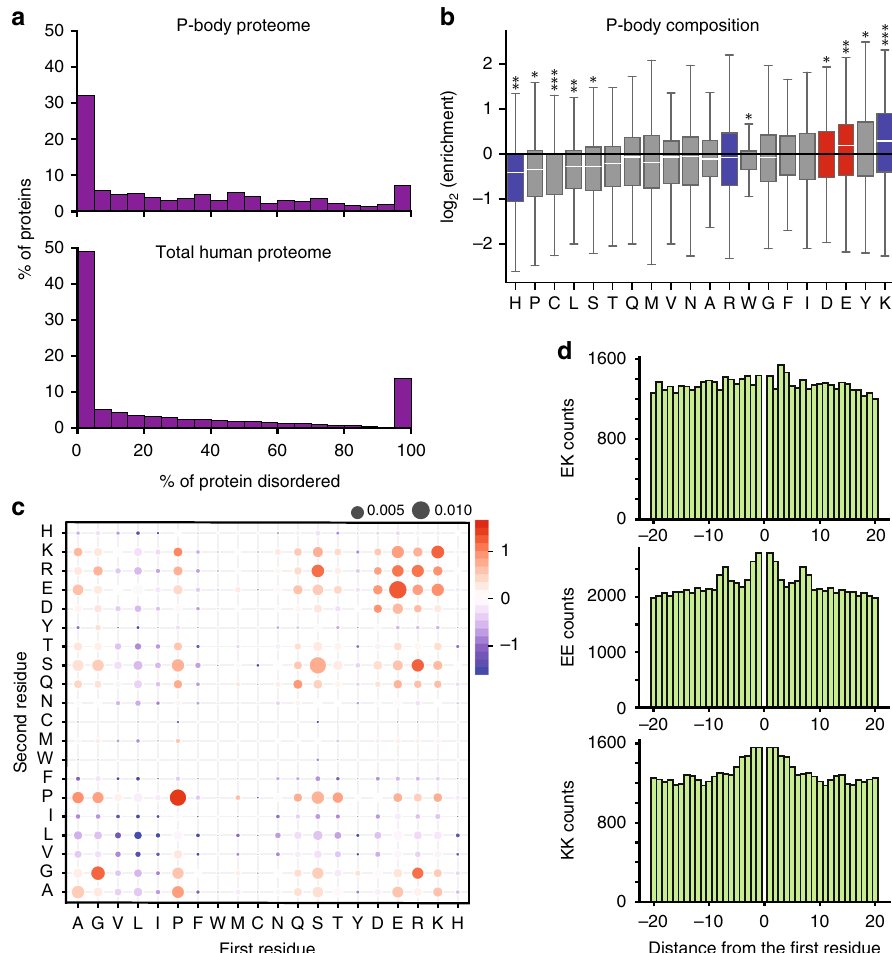
Fig. 1 Disordered protein regions in P-bodies are rich in lysine. a Distribution of the fraction of disorder predicted by IUpred for P-body proteins (top) and the entire human proteome (bottom). b Box plot of log2-fold enrichment of amino acids in disordered regions of P-bodies relative to disordered regions of the entire human proteome. Boxes and whiskers show, from bottom to top, 5%, 25%, 50%, 75%, and 95% quantiles. Red/blue: positively/negatively charged residues. p -values < 10 − 5 :*, < 10 – 10 :**, < 10 – 20 :***. c Log2 enrichment (red) or depletion (blue) of dipeptides in disordered regions of P-bodies relative to disordered regions of the entire human proteome. First residue on x -axis, second on y -axis. Size of circles: total probability of dipeptide (sum = 1). d Same charges cluster together in P-bodies, while opposite charges do not. Top: Total counts of amino acid K at position x relative to an E at position 0 ( fi rst residue) in disordered regions of P-bodies. Virtually no clustering is observed. Middle and bottom: Same for K/K and E/E instead of K/E. Residues of same charge are enriched within + / − 5 residues of each other. Source data are provided as a Source Data fi